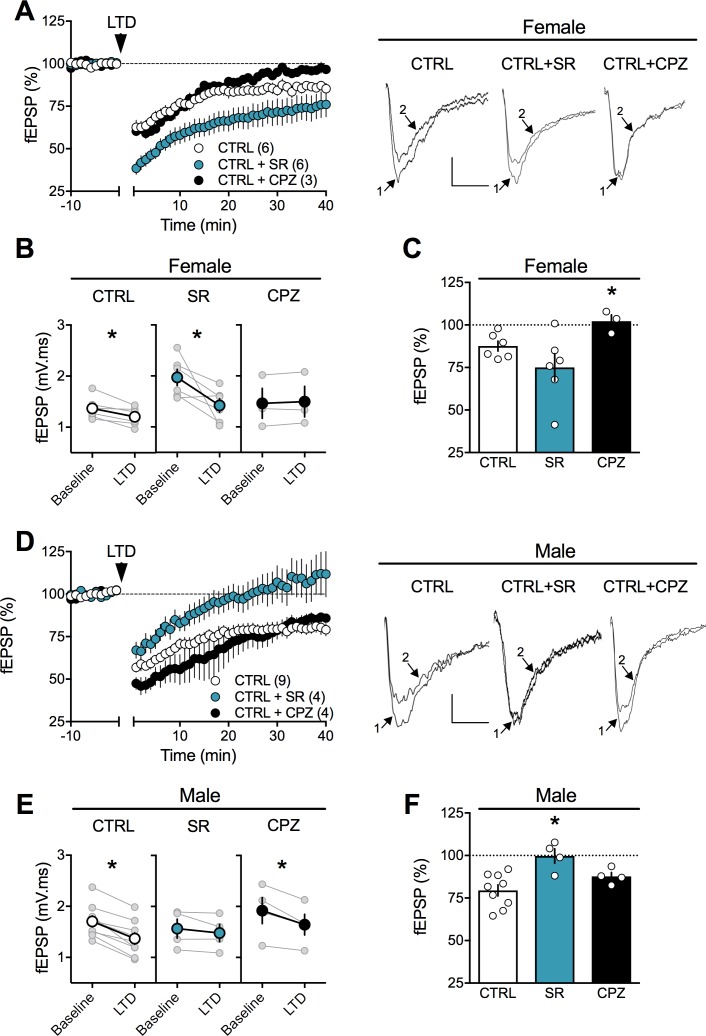
Sex-specific substrates of LTD in adult mPFC.(A) Time course of normalized field EPSPs recordings from layer 5 mPFC after 10 Hz stimulation protocol (10 min, arrow) in presence of CB1R antagonist SR141716 (SR, n = 6, blue circles) or TRPV1 antagonist Capsazepine (CPZ, n = 3, black circles) in naïve female rats. Right: example traces, baseline (1) and 40 min poststimulation (2)(B) Individual experiments (grey) and group average (tan circles), before (baseline) and after (40 min) LTD induction (arrow) showing that, in control female rat (CTRL, left), LTD is blocked by the TRPV1 antagonist (CPZ, right) but not by the CB1R antagonist (SR, middle). In control rats: 1.368 ± 0.089 mV.ms before LTD versus 1.205 ± 0.074 after LTD induction (n = 6; p<0.05, paired t-test). After SR141716A preincubation: 1.970 ± 0.160 mV.ms before LTD versus 1.420 ± 0.133 after LTD induction (n = 6; p<0.05, paired t-test). In control female, LTD induction requires activation of TRPV1 receptors: 1.463 ± 0.295 mV.ms before LTD versus 1.497 ± 0.300 after LTD induction (n = 3; p>0.05, paired t-test). (C) Bar chart summary of fEPSP percentage change from baseline 38–40 min after 10 Hz stimulation in control female (white bar) after treatment with CB1R antagonist (SR, blue bar) or TRPV1 antagonist (CPZ, black bar) (F(2, 12)=3.928; p<0.05, one-way ANOVA). (D) Time course of normalized field EPSPS recordings from layer 5 mPFC after 10 Hz stimulation protocol (10 min, arrow) in presence of CB1R antagonist SR141716 (SR, n = 4, blue circles) or TRPV1 antagonist Capsazepine (CPZ, n = 4, black circles) in naive male rats. Right: example traces, baseline (1) and 40 min poststimulation (2). (E) Individual experiments (grey) and group average (colors), before (bsl) and after (40 min) LTD induction showing that LTD in control male rats is CB1R-mediated (middle) rather than TRPV1-mediated (right). Low-frequency stimulation of mPFC slices triggers LTD in male (left, white): 1.704 ± 0.107 mV.ms before 10 Hz stimulation versus 1.367 ± 0.112 after LTD induction (n = 9; p<0.05, paired t-test). This LTD is blocked by CB1R antagonist SR141716A: 1.565 ± 0.185 mV.ms before and 1.480 ± 0.167 after LTD induction (n = 4; p>0.05, paired t-test). In contrast, in male rats, LTD is not blocked by TRPV1 antagonist: 1.917 ± 0.256 mV.ms before LTD versus 1.644 ± 0.204 after LTD induction (n = 4; p<0.05, paired t-test). (F) Bar chart summary of fEPSP percentage change from baseline 38–40 min after LTD induction in control male (white bar) after treatment with CB1R antagonist (SR, blue bar) or TRPV1 antagonist (CPZ, black bar) (F(2, 14)=7.623; p<0.05, one-way ANOVA). mPFC slices were preincubated for 45 min in 5 μM SR141716A and 10 μM Capsazepine. *p<0.05. n = individual rats. Error bars indicate SEM. Scale bar: 10 ms, 0.1 mV.